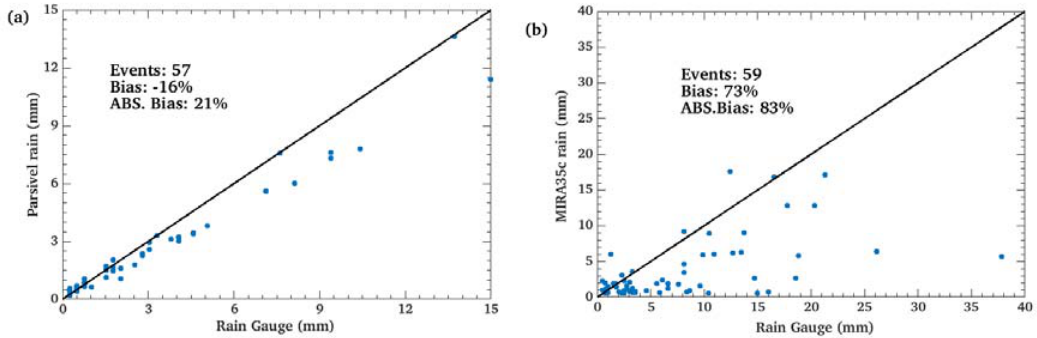
Figure 2. Comparison of the accumulated rainfall between ( a ) disdrometer and rain gauge and ( b ) rain gauge and MIRA35c.